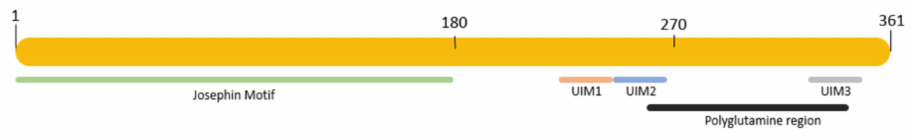
Figure 1. Representation of ataxin-3 protein with its main domains. Green, Josephin motif, positions 1–180; orange, UIM1 motif, positions 224–243; blue, UIM2 motif, positions 244–263; gray, UIM3 motif, positions 331–349; black, polyglutamine region, positions